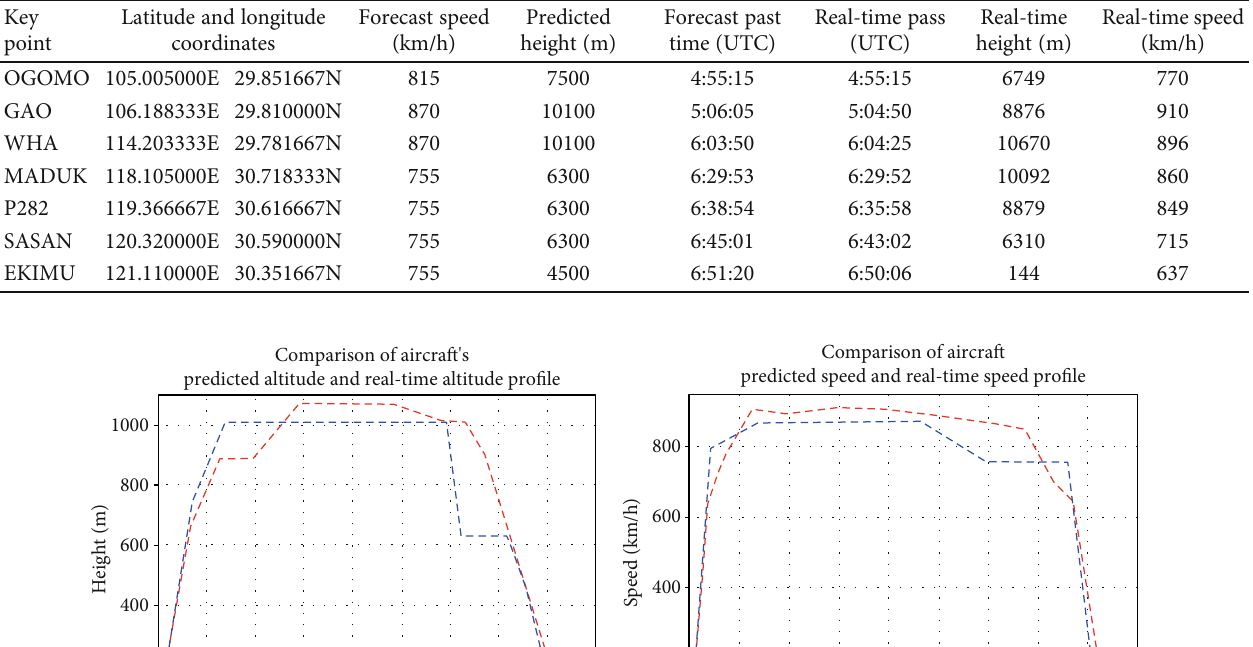
Table 1: CCA1532 waypoint parameters.